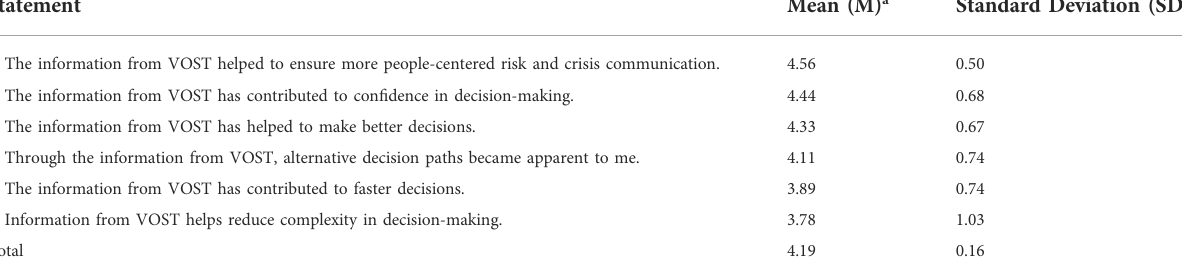
TABLE 5 VOST impact on